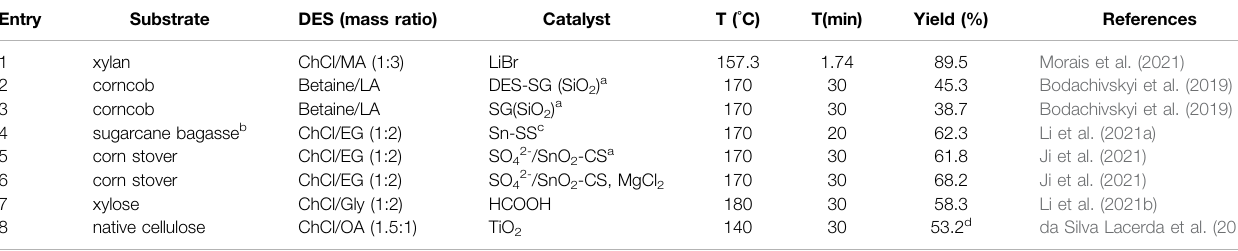
TABLE 5 | Effect of the catalysts on the furfural yield in the DES system.